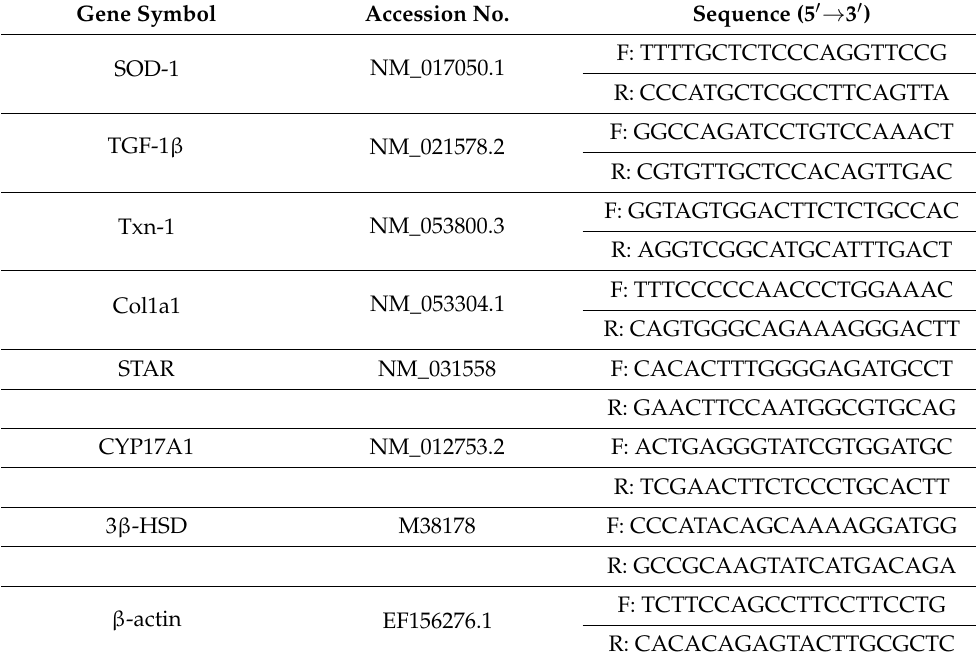
Table 1. RT-PCR primers for gene expression